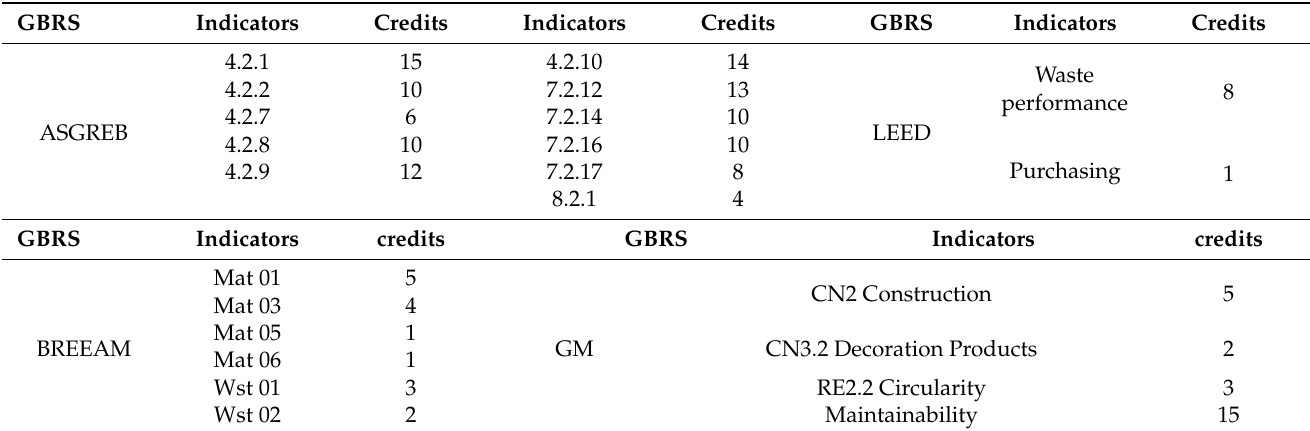
Table 6. Material scope CO 2 -related indicators